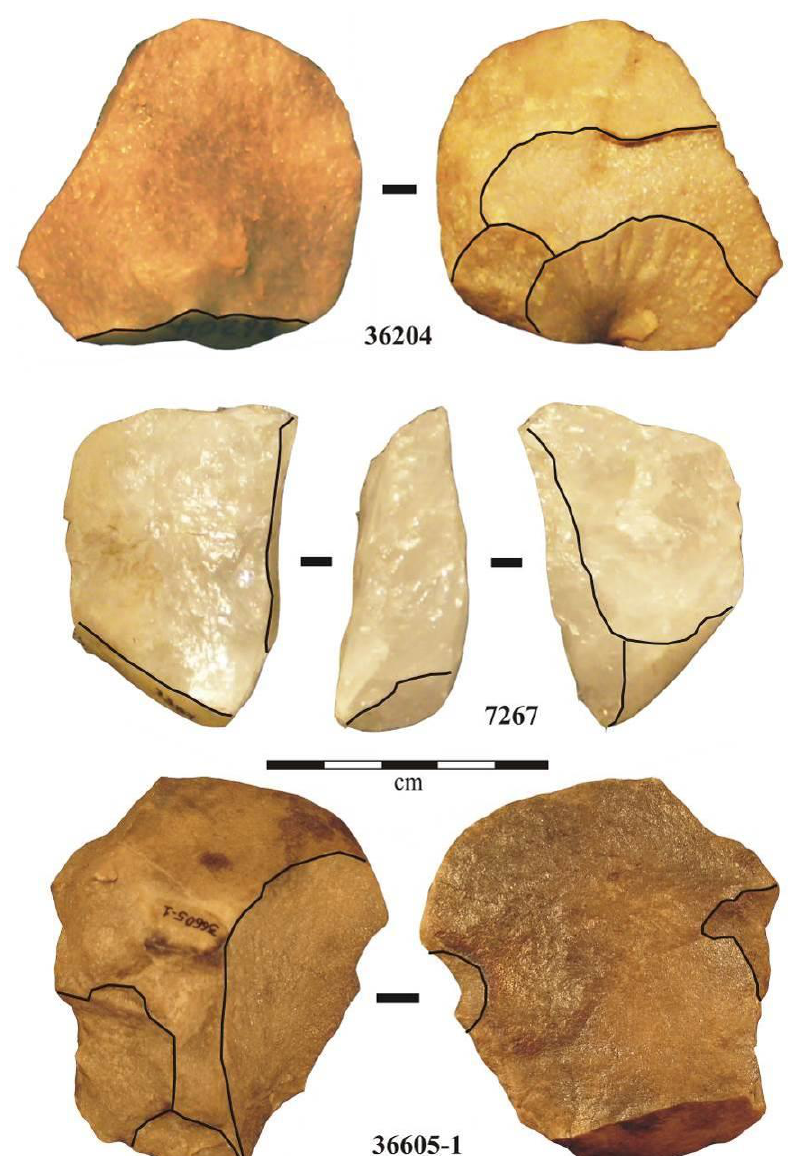
Figure 8. Flakes in quartz and quartzite from Pleistocene layer of Sitio do Meio, Pedra Furada 3 phase, older than uncal. 12,640 BP. Numbers refer to FUMDHAM inventory. (Photo by G.